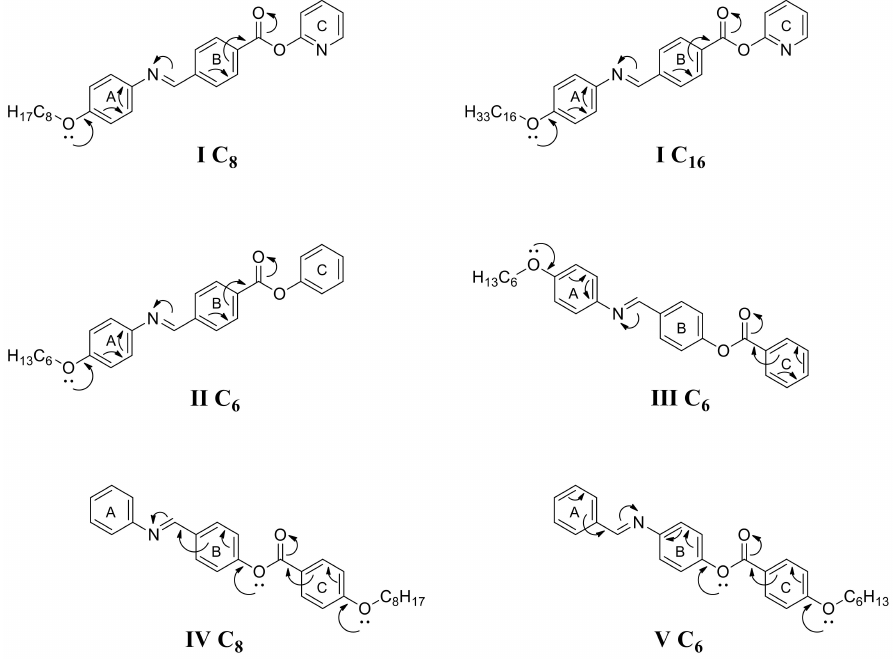
Figure 10. The proposed resonance of compounds I C 8 , I C 16 , II C 6 , III C 6 , IV C 8 , and V C 6